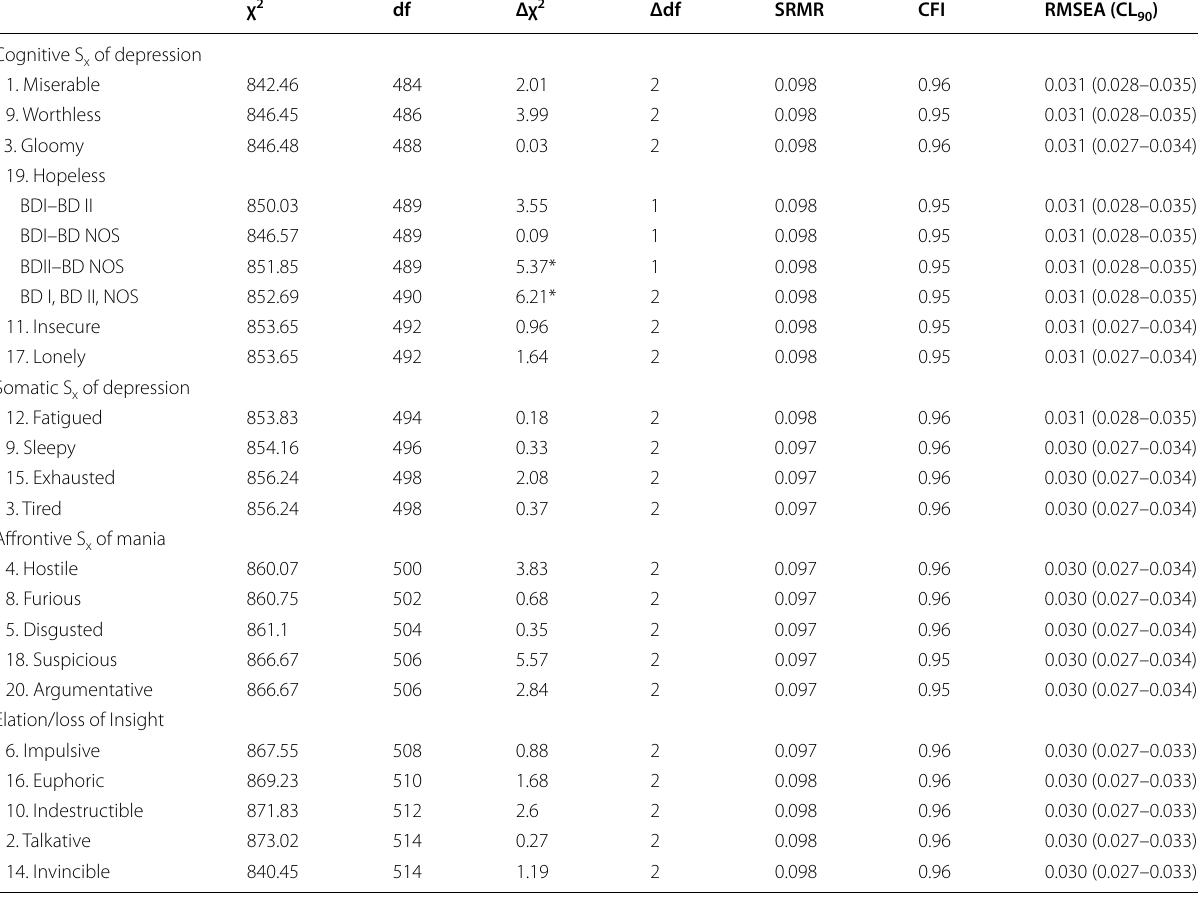
Table 4 BDS item comparisons—BD I, BD II, BD x